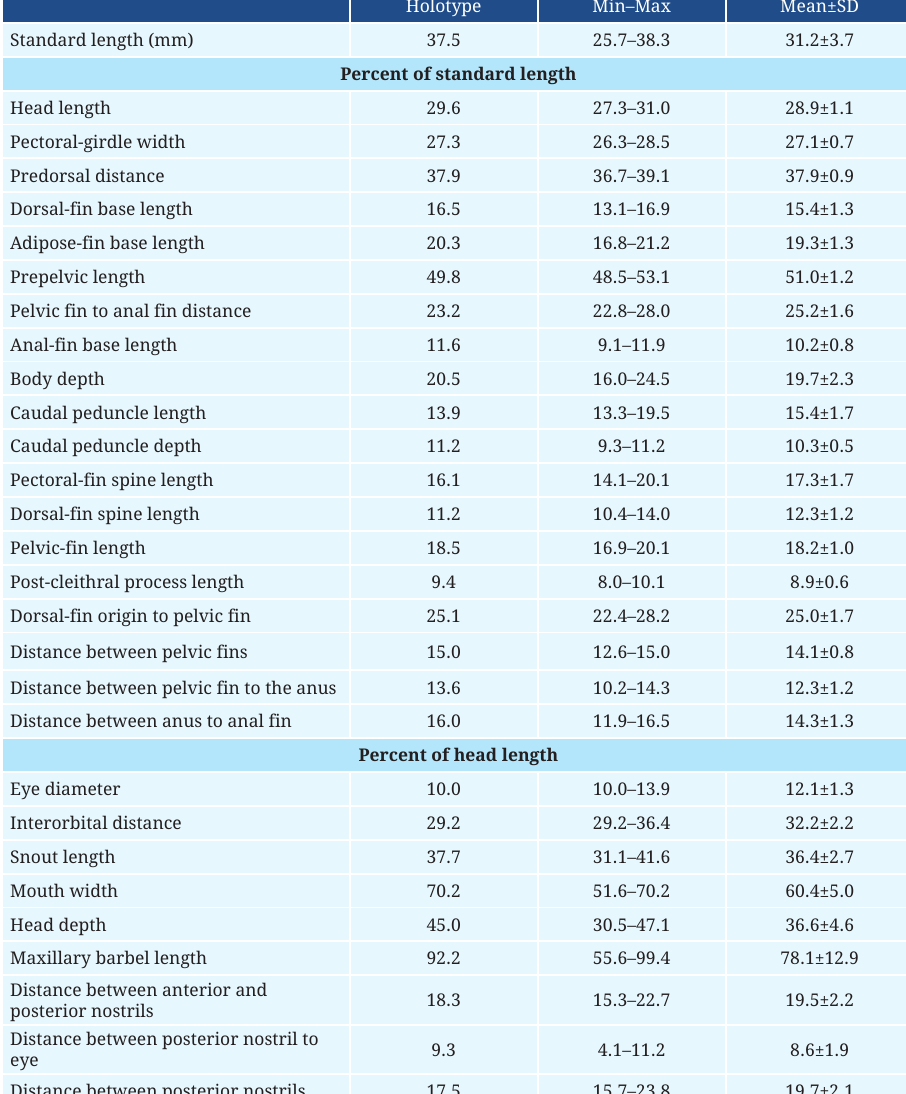
TABLE 1 | Body proportions of Rhyacoglanis rapppydanielae (N = 14; INPA 8060, holotype; MZUEL 20873, 10 paratypes, and INPA 7957, 3 paratypes) from rio Tocantins, state of Pará, Brazil. Statistics includes the holotype. Min = Minimum; Max = Maximum; SD = Standard